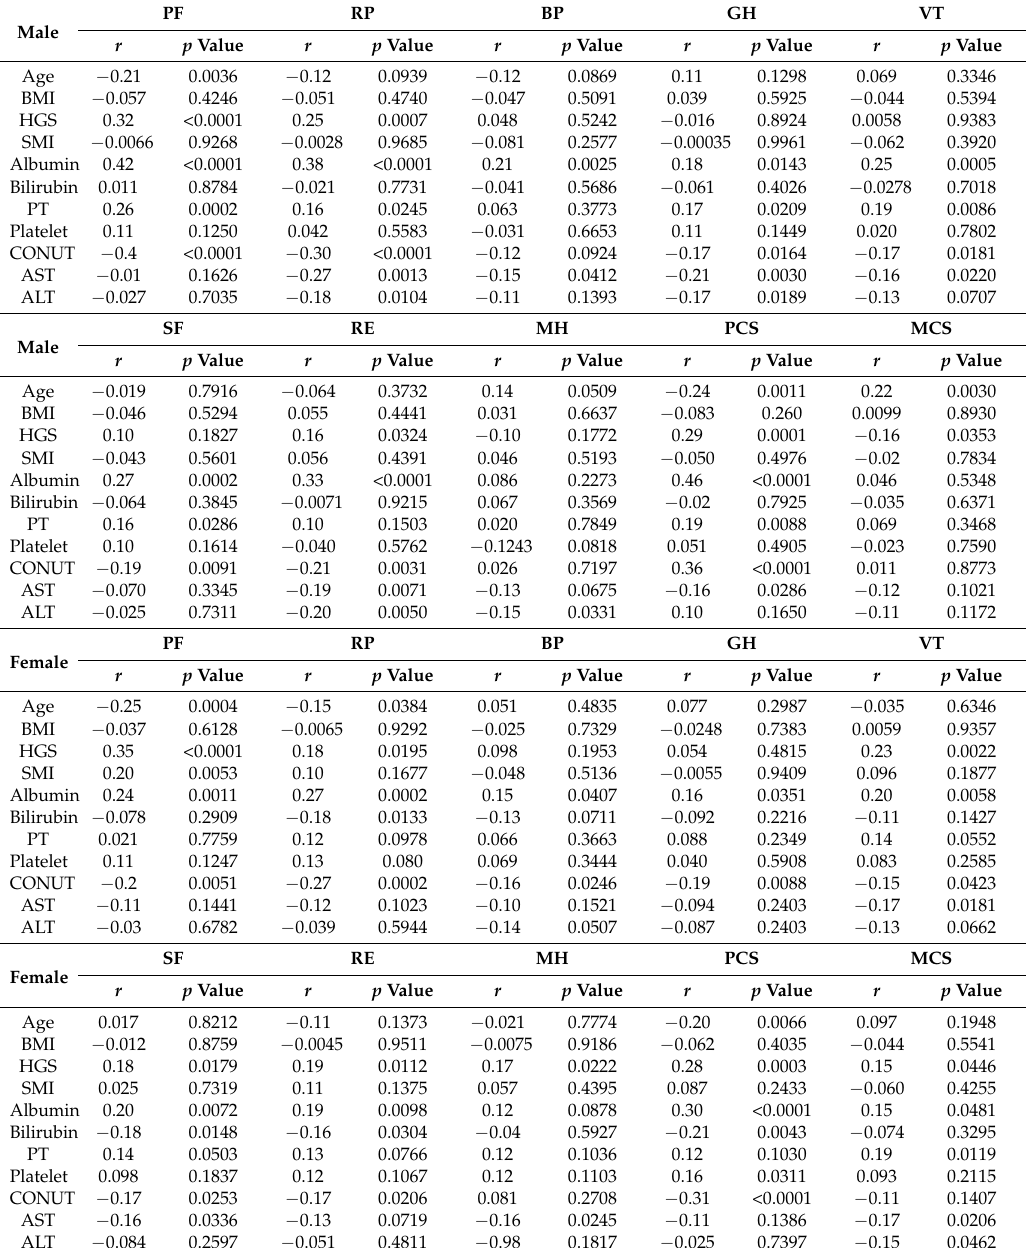
Table 4. Relationship between baseline data and the SF-36 scores in each item in male and female